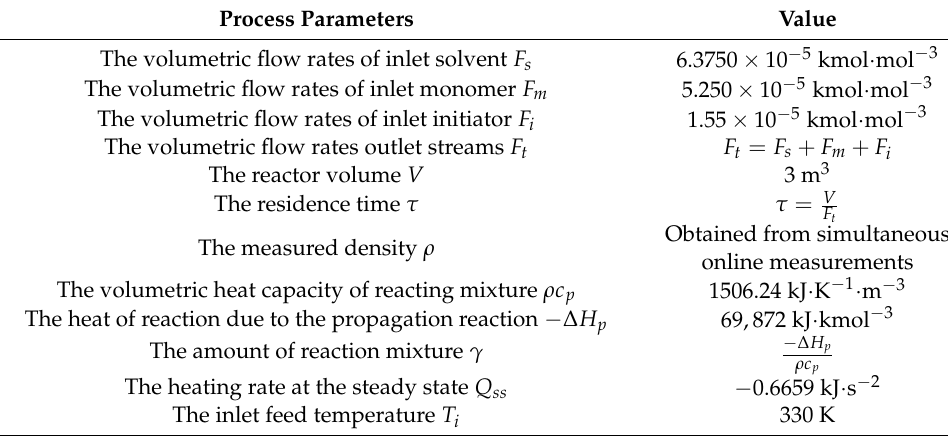
Table 3. Information of the states in Case Study 2. Standard Final Value at Initial Deviation Process States Steady State Value of Noise Dimensionless concentration of initiator (cid:101) C I , k 0.91 0.01 1 Dimensionless concentration of monomer (cid:101) C M , k 0.91 0.01 1 Dimensionless temperature of reactor (cid:101) T k 0.91 0.01 1 Table 4. Information of the parameters in Case Study 2. Process Parameters